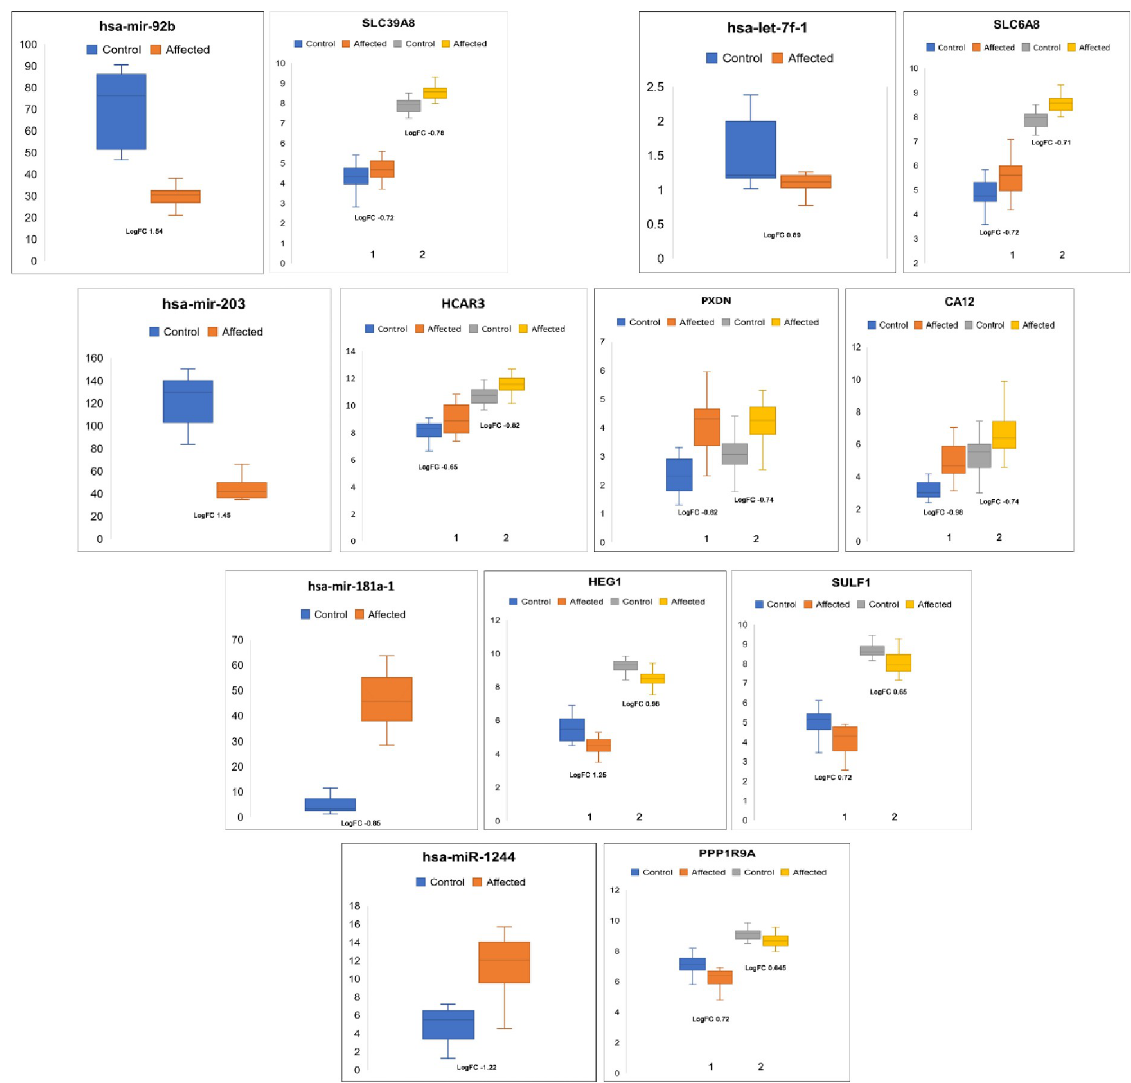
Fig 3. Inverse correlation expression of top four miRNA and its target genes in asthma